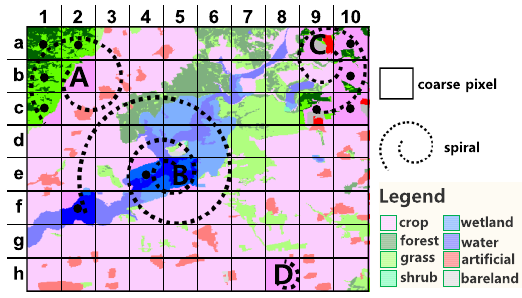
Figure 2. Examples of spiral-based method constructs adjacent pixel